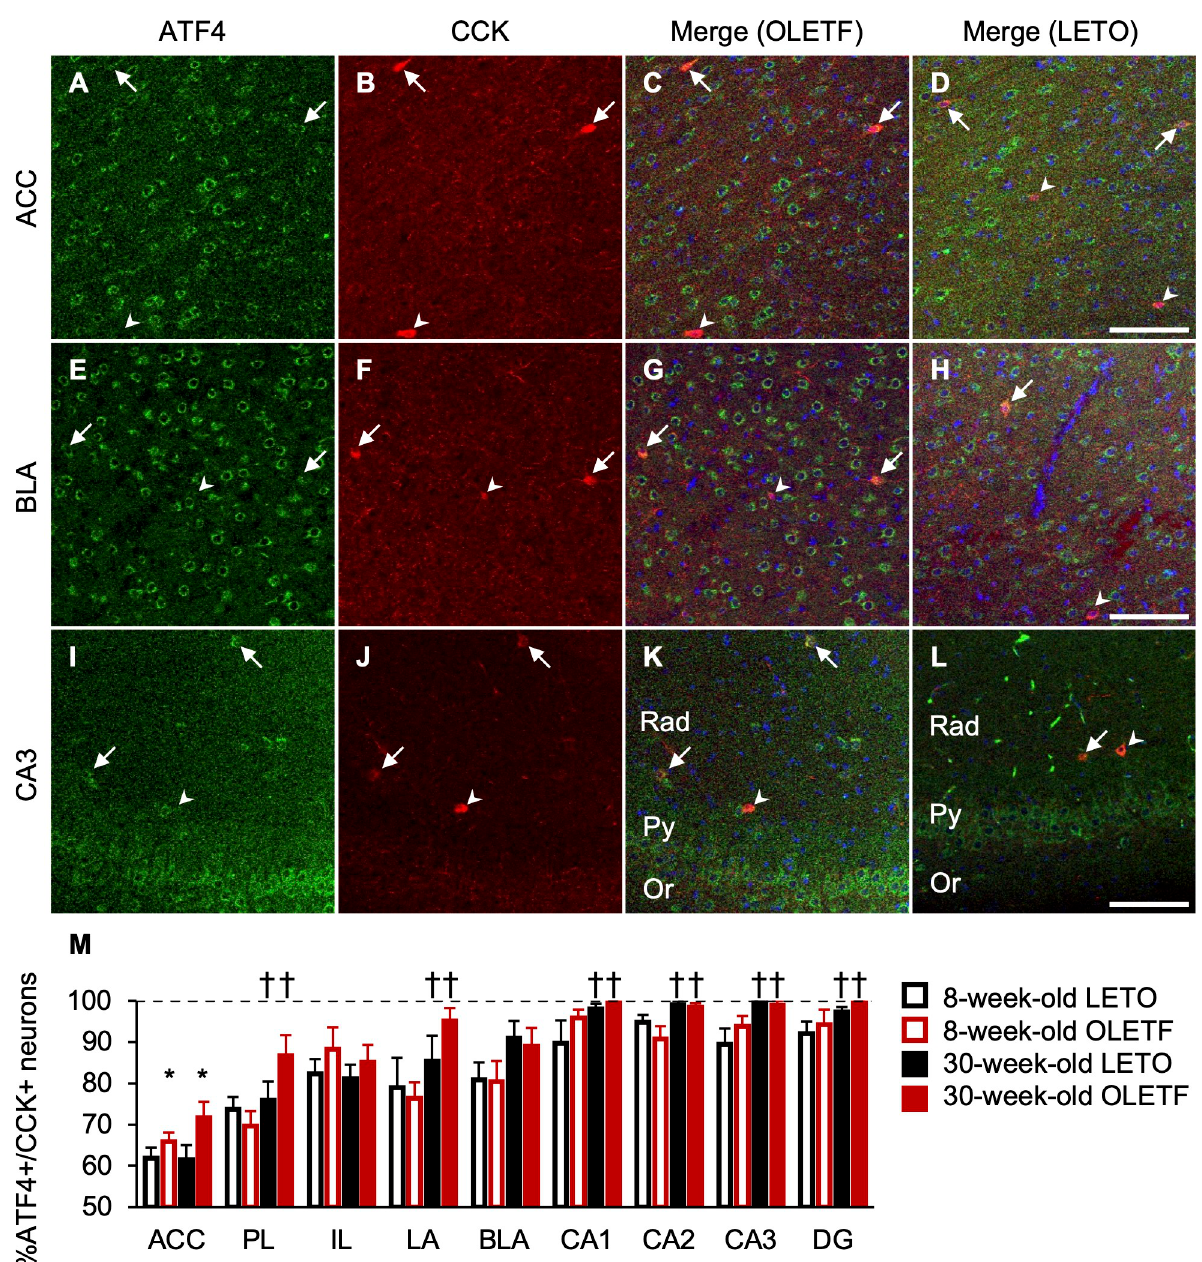
Fig 7. ATF4- and CCK-positive neurons in the corticolimbic system. Representative immunofluorescent images of 8-week-old OLETF and LETO rats in the anterior cingulate cortex (ACC; A , B , C , and D ), basolateral amygdala (BLA; E , F , G , and H ), and hippocampal cornu ammonis area 3 (CA3; I , J , K , and L ). Labeling for activating transcription factor 4 (ATF4; A , E , and I ) and cholecystokinin (CCK; B , F , and J ) and merged images ( C , G , and K for OLETF rats; D , H , and L for LETO rats). Arrows or arrow heads indicate neurons expressing ATF4 and CCK or only CCK, respectively. Scale bars = 100 μ m. Rad: radiatum layer; Py: pyramidal cell layer; Or: oriens layer. The percentages of neurons co-expressing ATF4 and CCK in the ACC, prelimbic cortex (PL), infralimbic cortex (IL), lateral amygdala (LA), BLA, CA1, CA2, CA3, and dentate gyrus (DG; M ). ATF4+: ATF4-positive; CCK+: CCK-positive. Values represent mean ± standard error of means. � Significant difference from age-matched LETO rats, p < 0.05; † significant difference from same strain at 8 weeks of age, p < 0.01, two-way ANOVA.